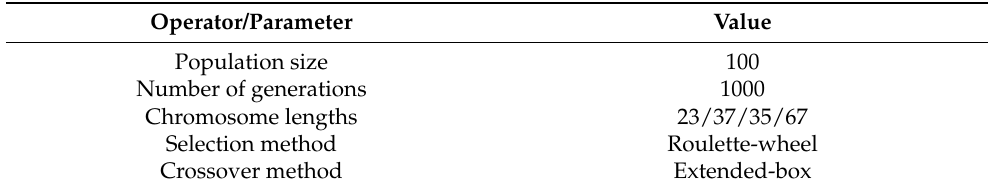
Table 2. Operators and parameters of the proposed SGA for the cart-pole balancing